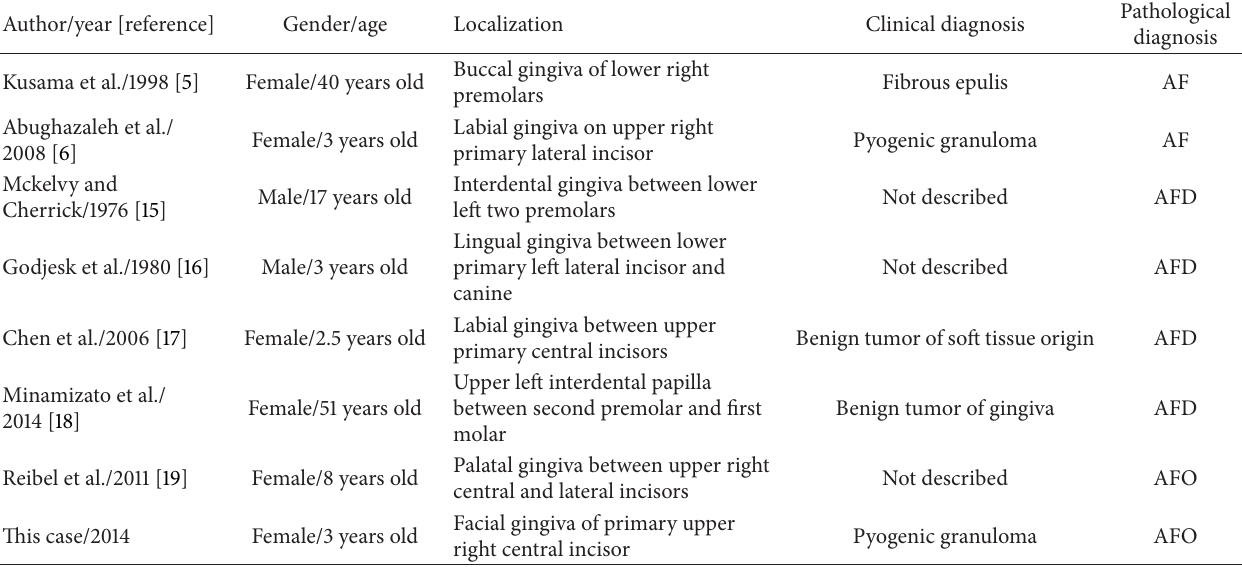
Table 1: Reported cases of peripheral ameloblastic fibroma (AF), ameloblastic fibrodentinoma (AFD), and ameloblastic fibro-odontoma